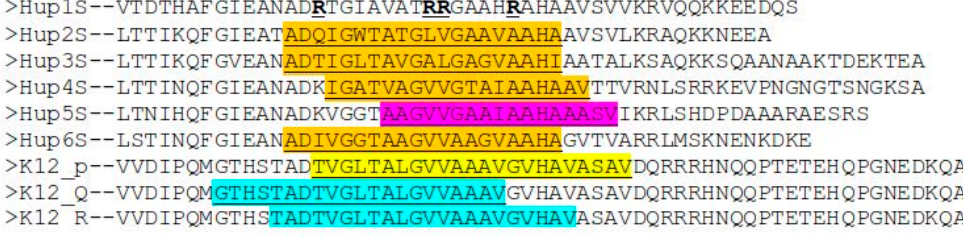
Figure 6. Predicted transmembrane helices in the modeled hydrogenases are highlighted in orange; a region in Rvi. gelatinosus showing a slight transmembrane propensity is colored magenta (explanation below); predicted helix in E. coli is highlighted yellow, and experimentally observed α -helices are colored cyan. Four arginine residues are shown in bold type: their substitution to corresponding residues from Hup2 leads to prediction of alpha-helix. Hup1S -HupS from Tca. roseopersicina ; Hup2 -HupS from Rba. capsulatus ; Hup3S -HupS from Rba. sphaeroides ; Hup4S -HupS from Rps. palustris ; Hup5S -HupS from Rvi. gelatinosus ; Hup6S -HupS from Rsp. rubrum ; K12_p- Hyd-1 from E. coli , TMHMM prediction ; K12_Q-Hyd-1 from E. coli , PDB ID: 4GD3 , chain Q , transmembrane region ; K12_R-Hyd-1 from E. coli , PDB ID: 4GD3 , chain Q , transmembrane region .